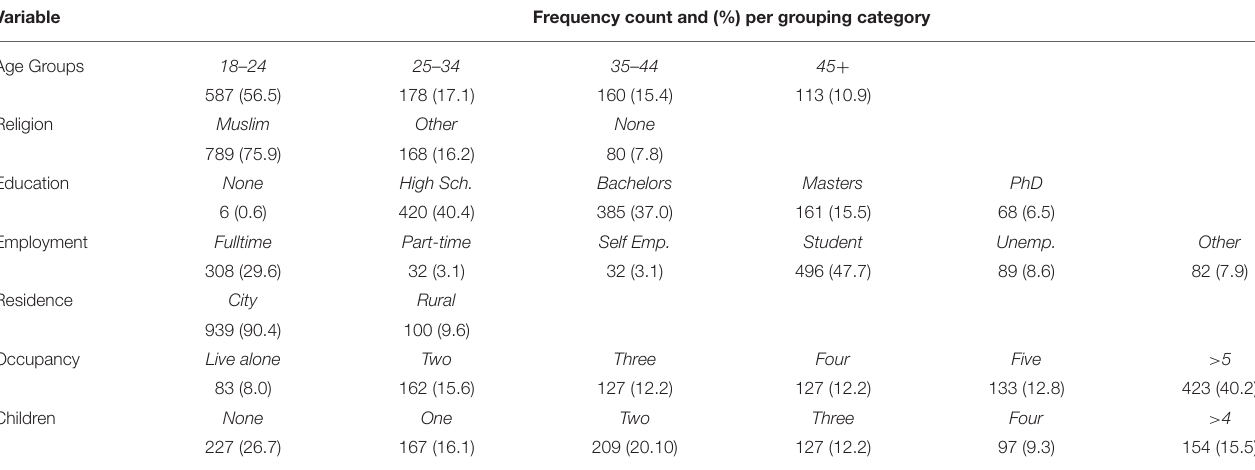
TABLE 3 | The frequency count and (percentage) for the study’s main demographic variables. Variable Frequency count and (%) per grouping